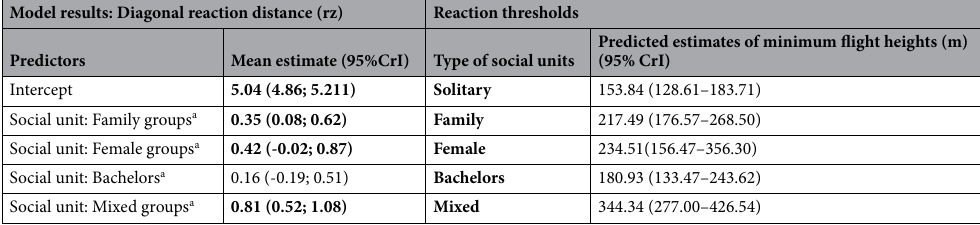
Table 3. Results from a generalized linear model for diagonal reaction distance (rz) and estimated reaction thresholds. We present estimates of the parameters with their 95% credible intervals (CrI) in brackets. A statistically meaningful effect of a fixed factor (presented in bold) can be assumed if zero is not included within the 95% CrI or if the mean difference between compared estimates is higher than 0.95. a Reference level: Solitary